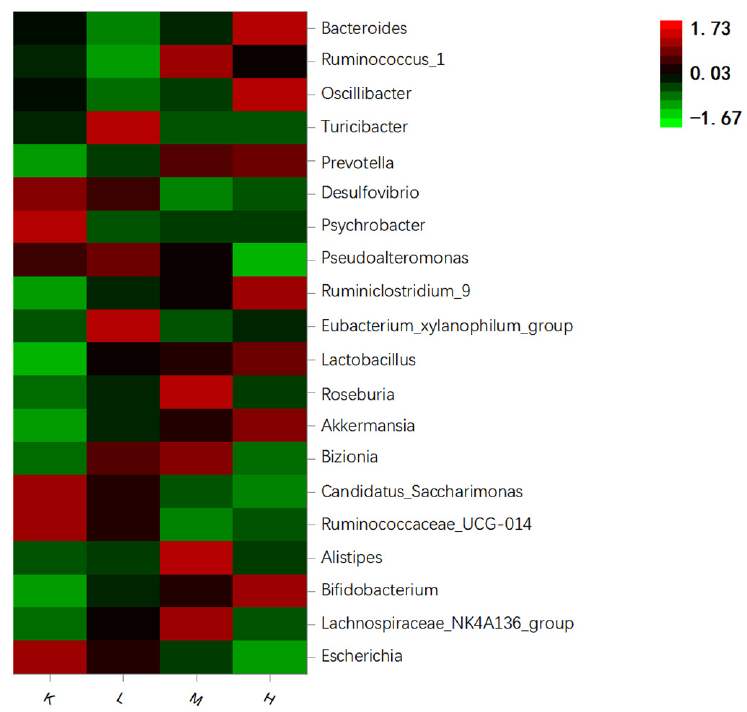
10 of 16 Figure 8. The ratio of Bacteroidetes/Firmicutes in the intestinal flora of mice. Different lowercase letters indicate significant differences ( p < 0.05). 3.7.2. Species Composition Analysis at the Genus Level Desulfovibrio , Ruminococcaceae_UCG-014 , and Candidatus_Saccharimonas were in group K. After the oral administration of anthocyanins, Prevotella , Akkermansia , Lactobacil- lus , and Bifidobacterium were the main species (Figure 9). After the oral administration of anthocyanins, compared with the K group, the proportion of Escherichia coli was signifi- cantly decreased ( p < 0.01), the proportion of Desulfovibrio was significantly decreased (p < 0.05), and the proportion of Prevotella and Lactobacillus significantly increased. ( p < 0.05).